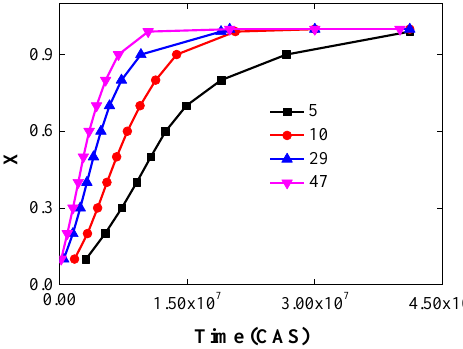
Figure 8. The area fraction vs. time.